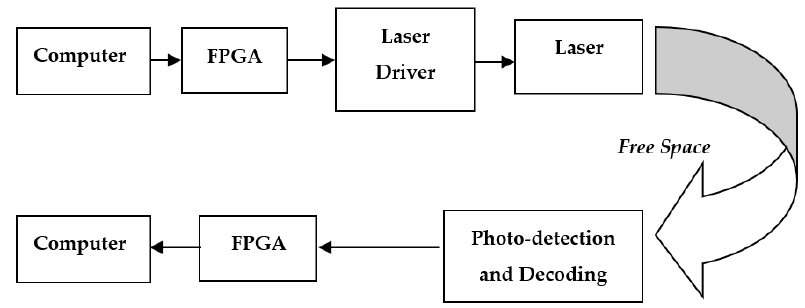
Figure 2. System Block Diagram.